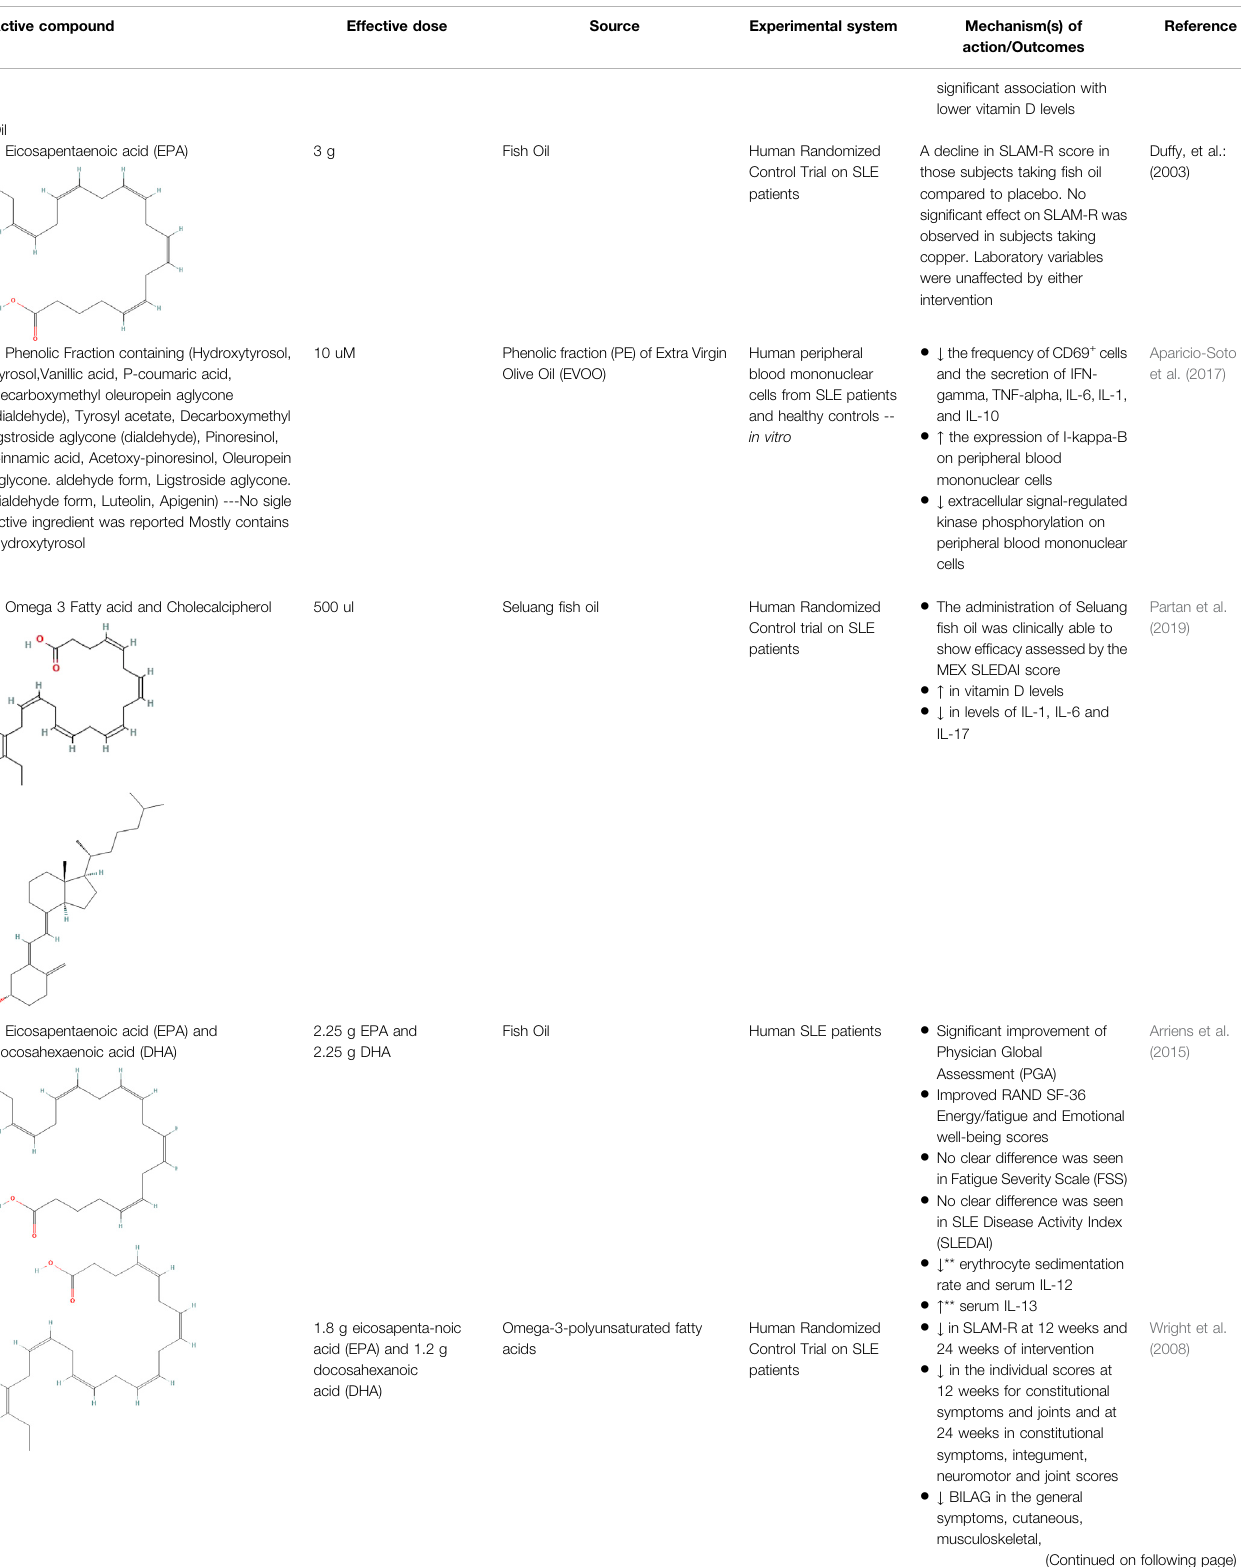
TABLE 1 | ( Continued ) Synthesized fi ndings for potential bioactive compounds for